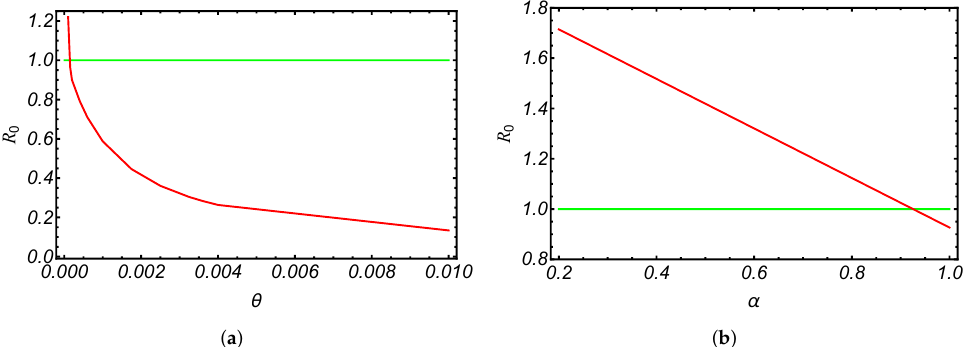
Figure 8. The curve of the basic reproduction number R 0 is shown in red, plotted against ( a ) the vaccine coverage rate β 0 and ( b ) vaccine efficacy α . The green line represents R 0 =